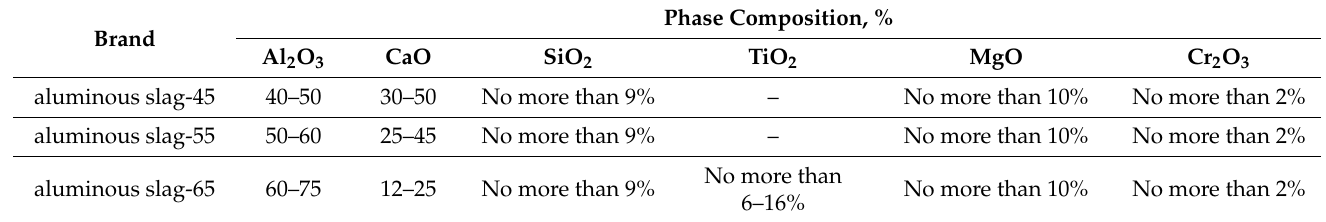
Table 9. Chemical composition of alumina slags for the production of clinkers according to GOST TU 14-11-347-2000